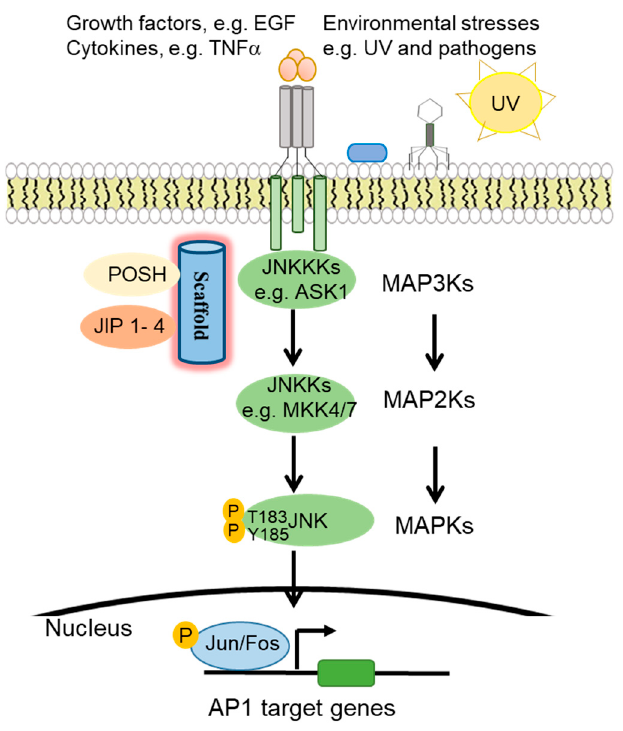
Figure 1. c-Jun N-terminal kinase (JNK) signaling pathway activation. In response to environmental stresses, growth factor, and cytokines, JNKKKs such as ASK1 phosphorylates JNKKs, specifically MKK4 and MKK7, which then activate JNK and finally the transcription factor activator protein-1 (AP1) family proteins.